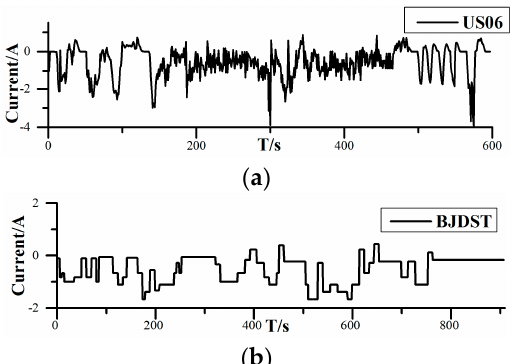
Figure 3. The relation diagram of open-circuit voltage (OCV)–state of charge (SOC) at different temperatures.